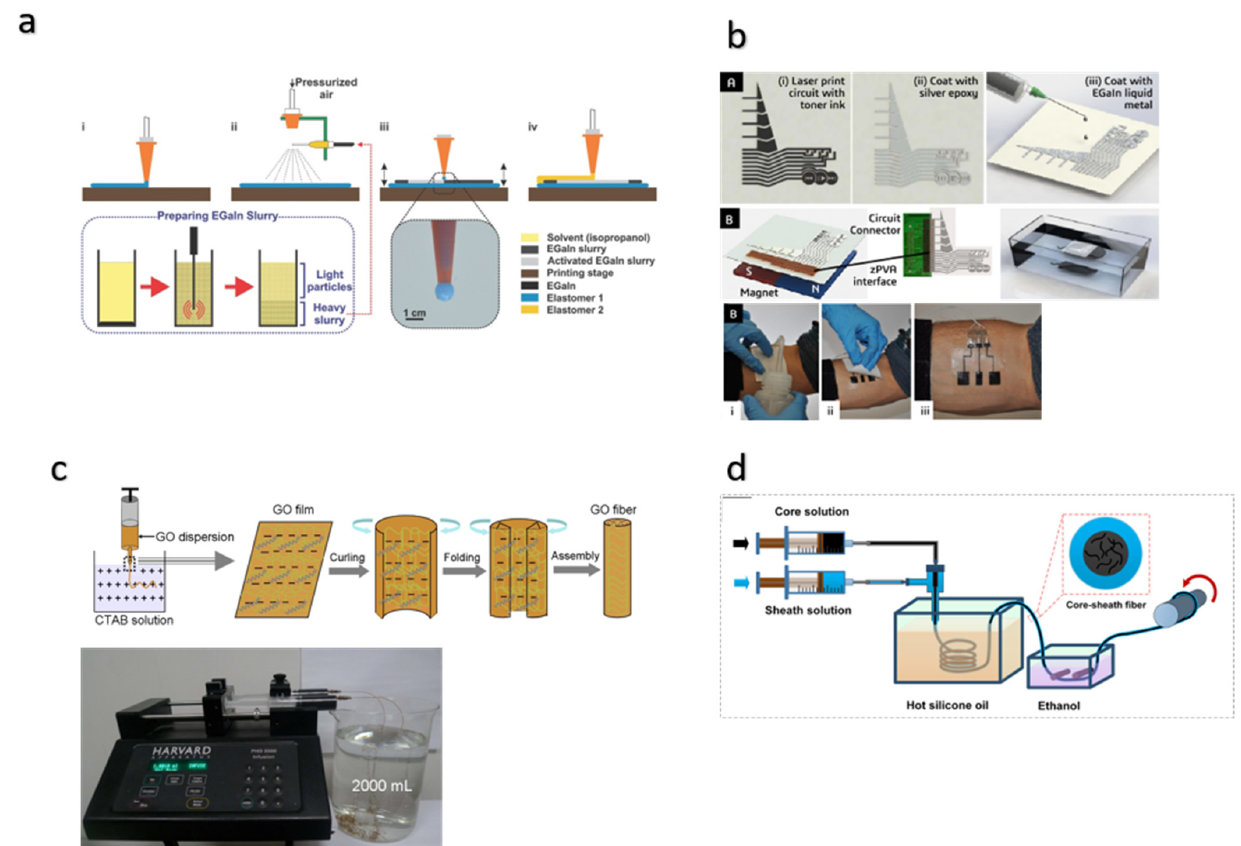
Figure 8. Alternative fabrication methods. ( a,b ) Printing method. ( a ). Schematics of printing of